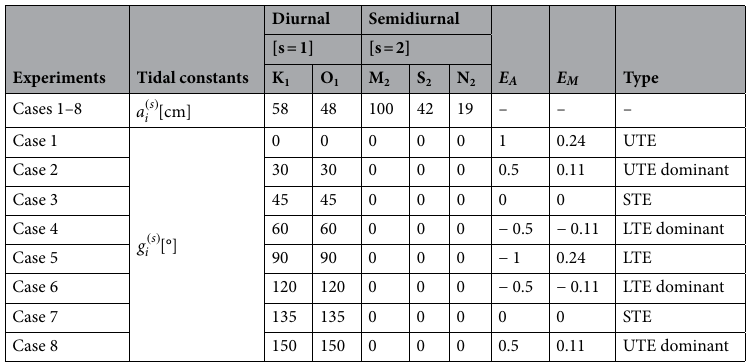
Table 1. Amplitude and phase lag input values for simplified tidal envelope generating experiments. All simplified experiments represent mixed mainly semidiurnal regimes (tidal form number F = 0.75). Amplitude ( s ) g ( s ) ( a i ) and phase lag ( i ) values are based on the Equilibrium Theory amplitude ratios between 5 major tidal constituents (K 1 , O 1 , M 2 , S 2 , and N 2 ) and E A = cos ( I A ) with the diurnal inequality phase lag relationship, I A = ( g K 1 + g O 1 ) − g M . s indicates tidal species, while i indicates each tidal constituent. E M is the difference 2 between the mean upper tidal envelope and absolute mean lower tidal envelope (see Eq. (9)). UTE is upper tidal envelope (with subcategories ‘UTE’ which has an upper curve that almost perfectly matches the maximum potential upper tidal envelope, and ‘UTE dominant’ which has an upper curve that closely approximates the maximum potential upper tidal envelope) and ‘LTE’ denotes lower tidal envelope (with two equivalent subcategories). STE denotes a near symmetrical tidal